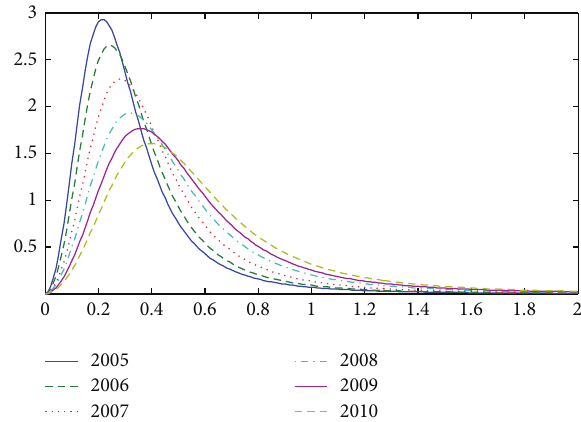
Figure 2: Income distribution of urban residents from 2005 to 2010. Note that the revenue unit is 100 thousand.